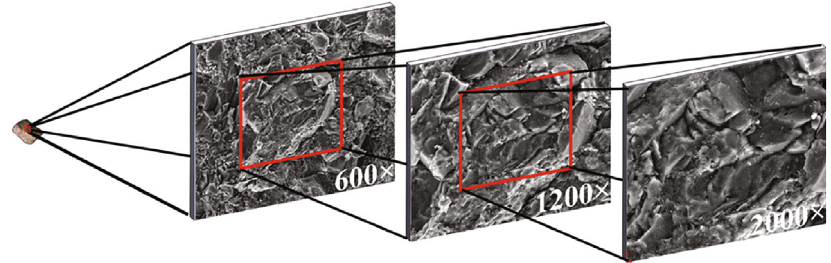
Figure 4: SEM images of di ff erent scales of a sandstone sample.